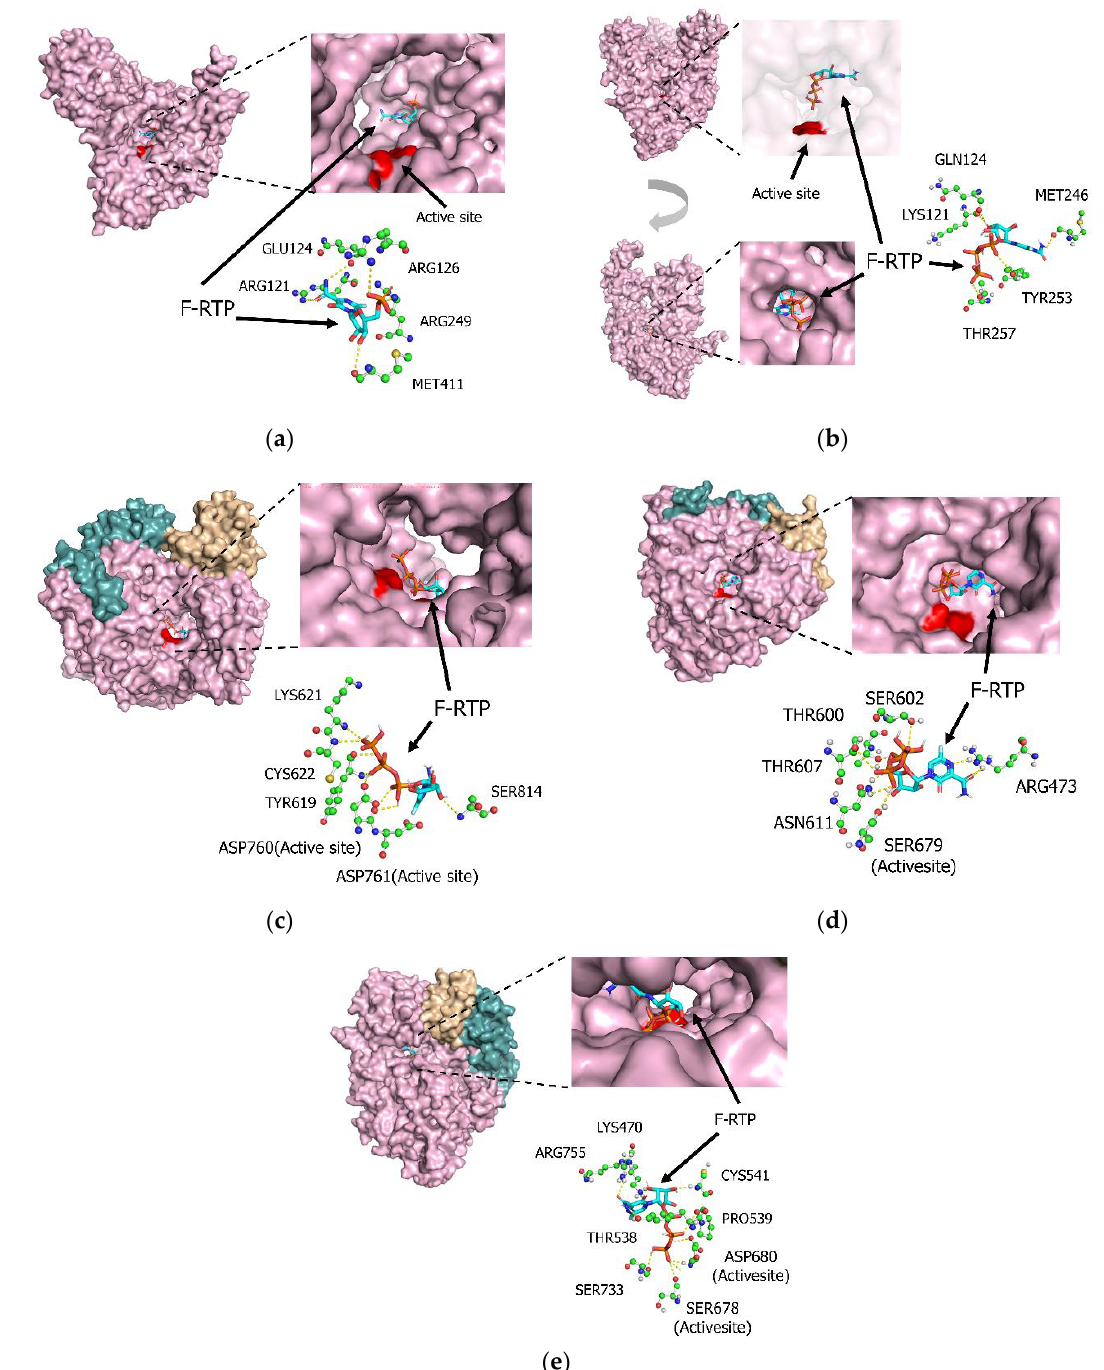
Figure 1. Detailed interactions between favipiravir ribofuranosyl-5′-triphosphate (F-RTP) and the active sites (red-colored regions) of ( a ) influenza H3N2 PB1 protein, ( b ) influenza H1N1 PB1 protein, ( c ) severe acute respiratory syndrome coronavirus-2 (SARS-CoV-2) RNA-dependent RNA polymerases (RdRp), ( d ) SARS-CoV RdRp, and ( e ) Middle East respiratory syndrome coronavirus (MERS-CoV) RdRp. Three-dimensional configurations of F-RTP and proteins were constructed with space-filling or stick models.